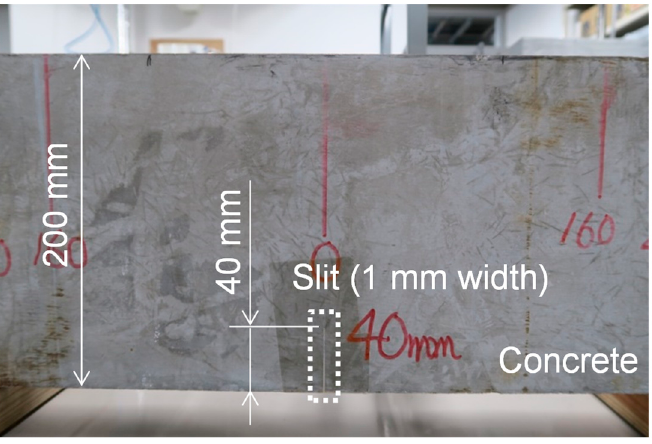
Figure 10. Concrete specimen with a slit (1 mm width, 40 mm height).